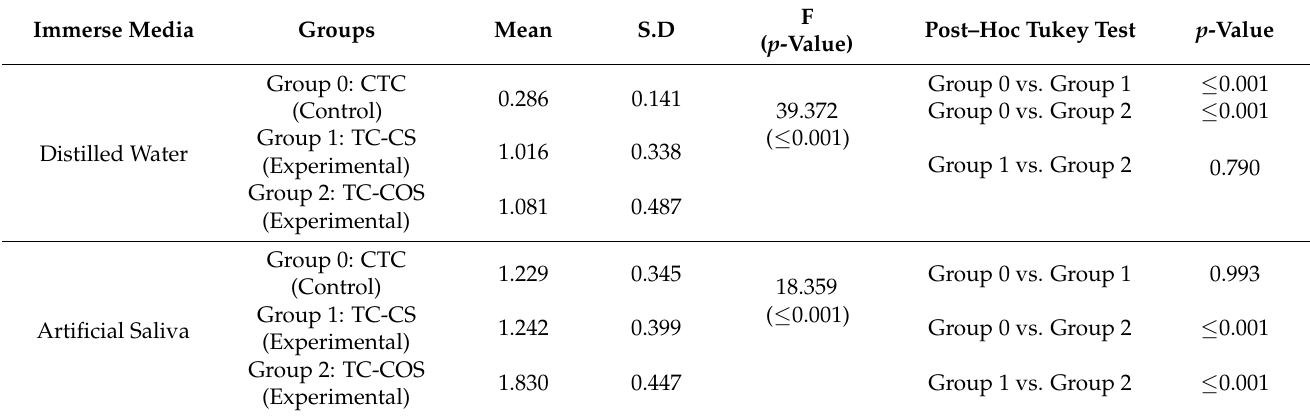
Table 4. Comparison of mean percentage solubility of specimens in different storage